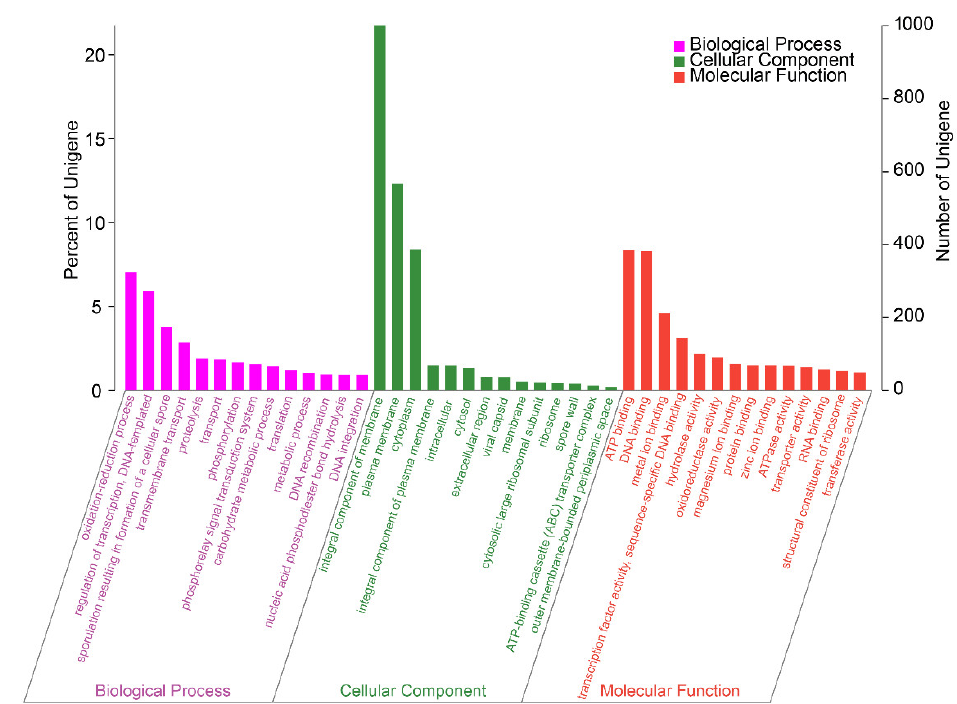
Figure 6. GO annotation classification of the B. subtilis A-5 genome.